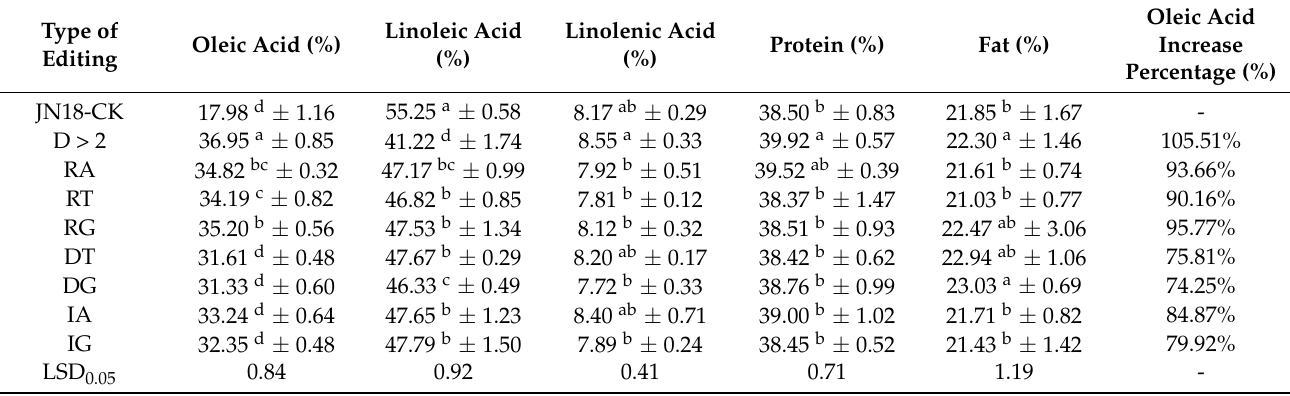
Figure 12. Comparison of quality traits of gene editing positive plants. Significant differences according to Student’s t -test are indicated. ** and *** indicated significant differences at p < 0.05, p < 0.01, and p < 0.001 levels, respectively. All data shown are means ± SD of three biological replicates. Table 3. Determination of fatty acid content of different edit types in T 2 plants.